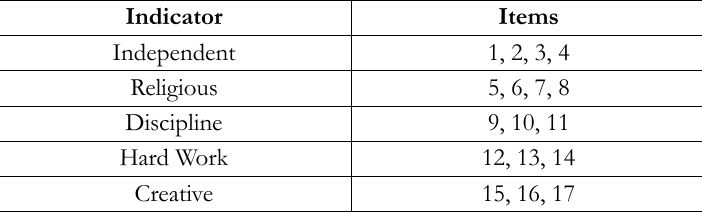
Table 2. Indicator of Character